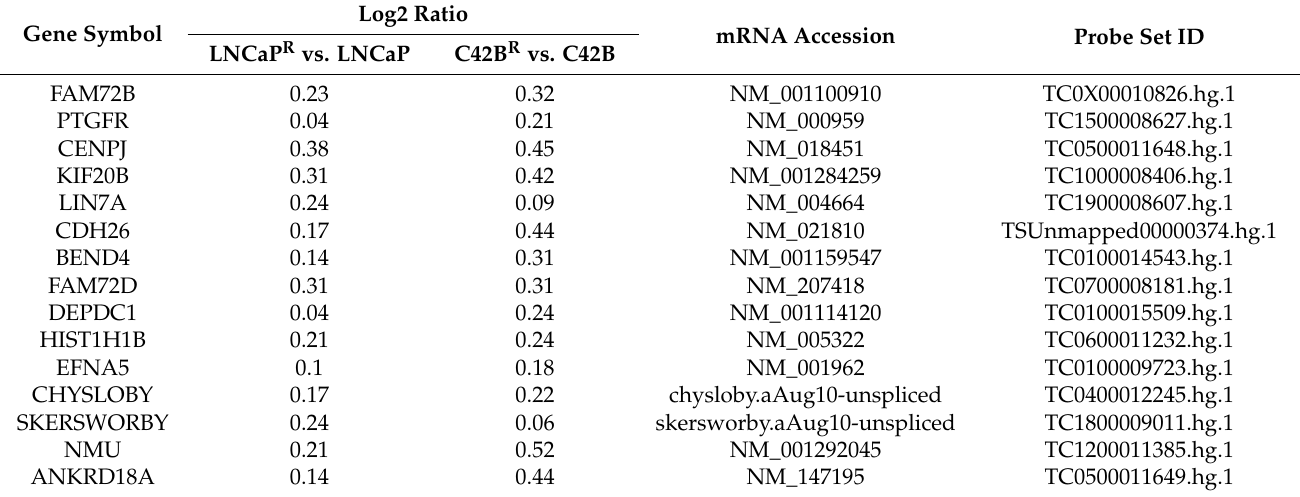
Table 2. Down-regulated genes in both LNCaP R and C4-2B R